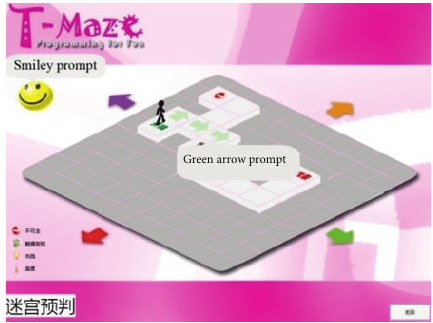
Figure 4: Interface of one level maze-escape game.